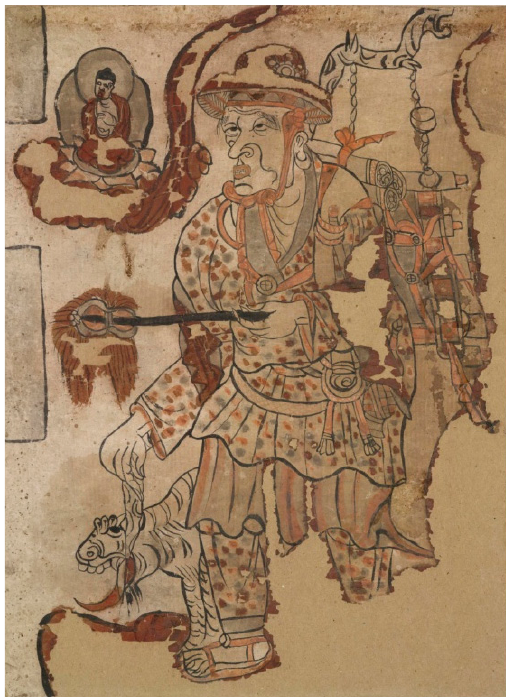
Figure 4. Itinerant Monk . Dunhuang, 10th century. Ink and colors on paper, 41.0 × 29.8 cm. The British Museum (1919,0101,0.168). © The Trustees of the British Museum.